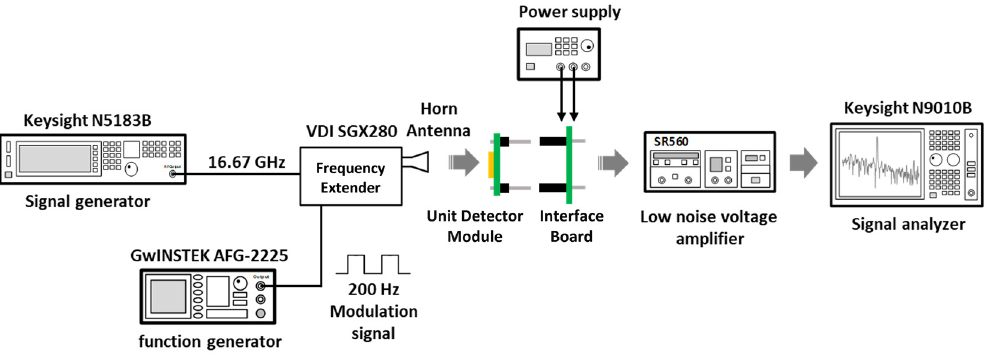
Figure 12. Experimental setup for measuring the voltage responsivity of the detector unit module.